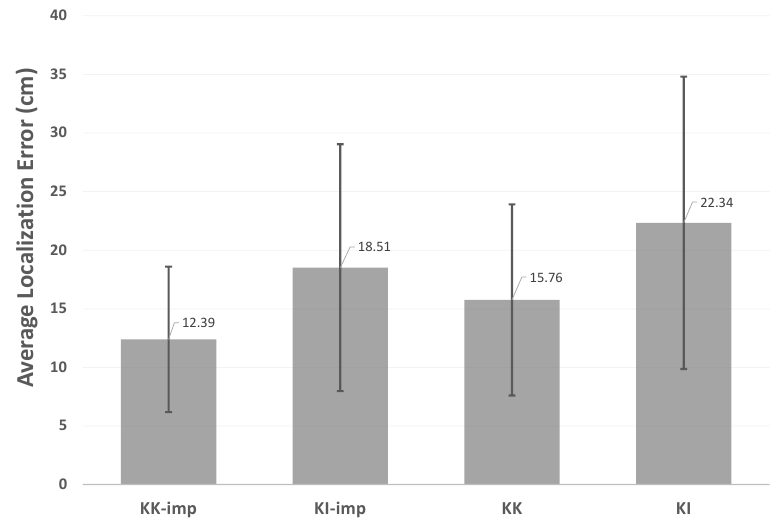
Figure 21. Mean localization errors for all the localization algorithms under acoustic